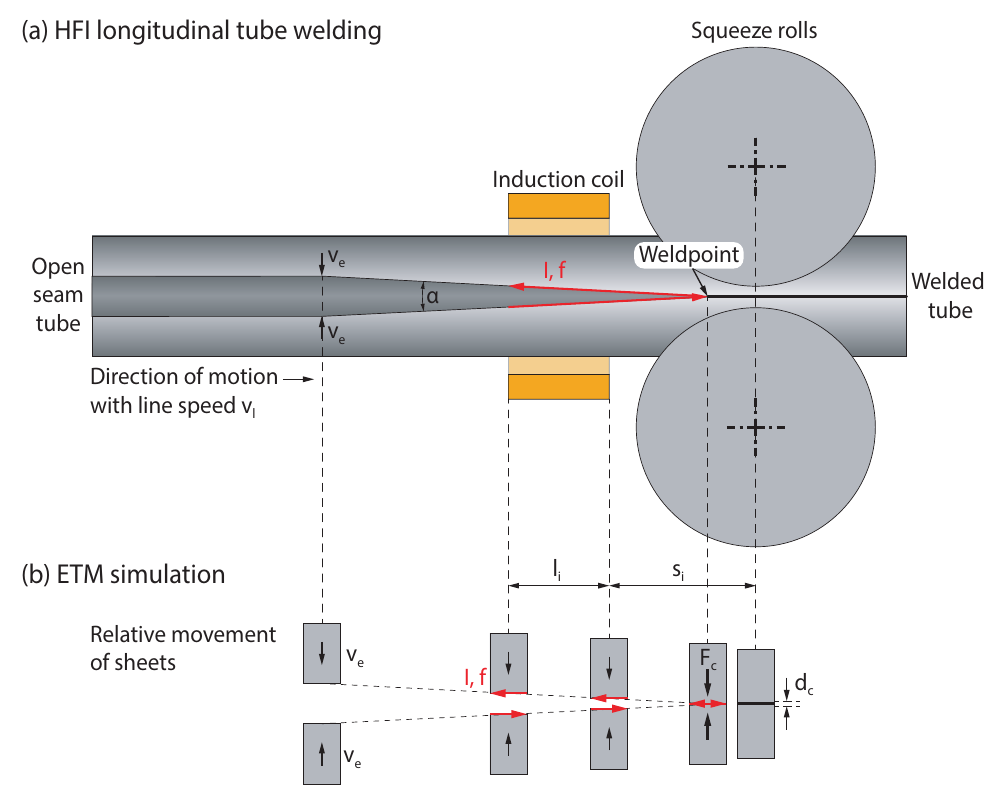
Figure 1. Comparison of ( a ) the HFI longitudinal tube welding process with ( b ) the experimental ETM